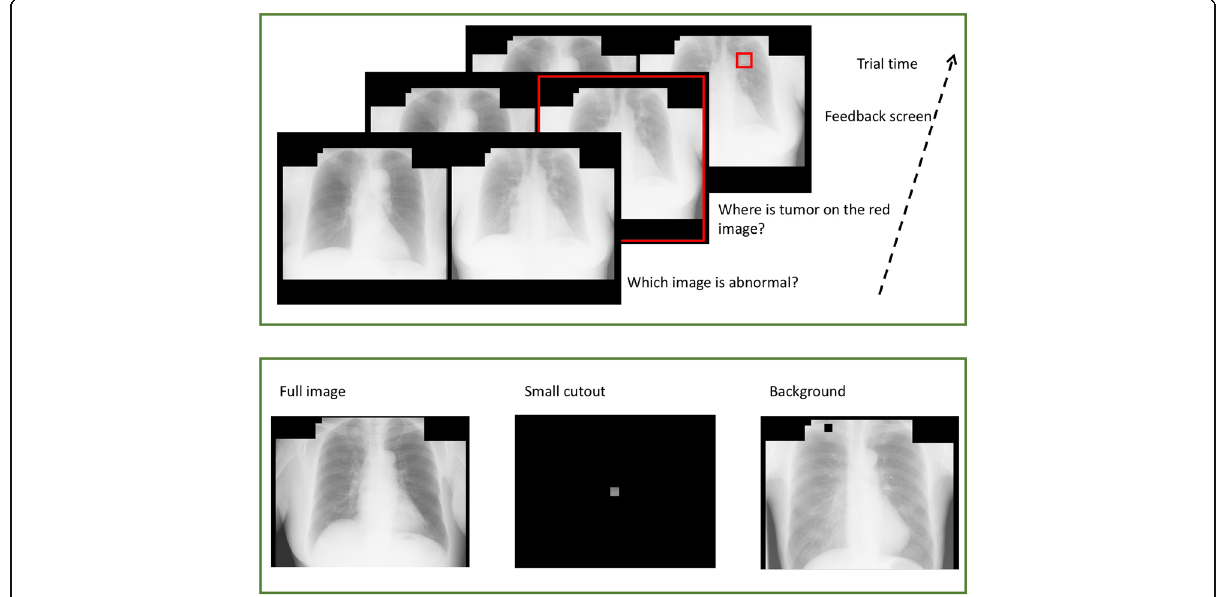
Fig. 1 Sample stimuli used in this study. Images were reproduced from the Japanese Society of Radiological Technology Database (Shiraishi et al., 2000). Top: in the training sessions, a pair of normal and abnormal images were presented. Participants clicked on the image that was abnormal. Following their response, a red frame indicated which image was abnormal. Participants then clicked on where they thought the tumor was. This was followed by a feedback screen that indicated the location of the tumor. Bottom: three formats used in the testing sessions